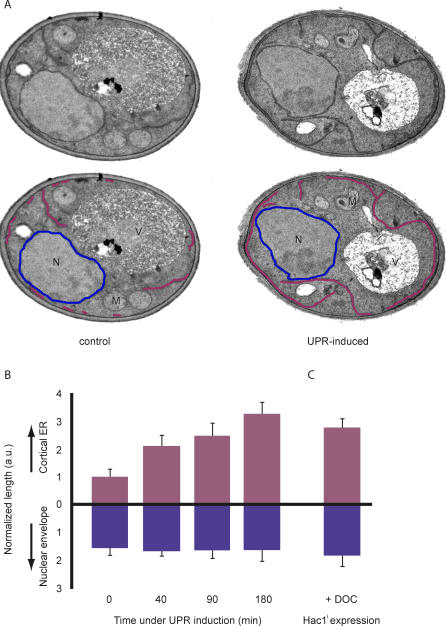
ER Proliferation under UPR-Inducing Conditions(A) Determination of ER abundance in control and UPR-induced cells. Representative cells are shown. The UPR was induced in wild-type cells by addition of DTT. Ultrastructure of control cells and UPR-induced cells was analyzed using ImageJ. The lower images show traces of cortical ER (represented in magenta) and the nuclear envelope (NE, in blue). Vacuoles, nuclei, and mitochondria are indicated as V, N, and M, respectively.(B) Quantification of the ER proliferation during the UPR. UPR was induced and cells were collected for EM at the indicated time points. Length of the ER (as traced in [A]) was measured and divided by the area of the section. Data are plotted relative to time 0. Measurements for each time point correspond to the mean of 25 independent cell images.(C) Expression of HAC1i was induced by addition of 100 μM DOC for 3 h. ER was quantified as described above in (B).